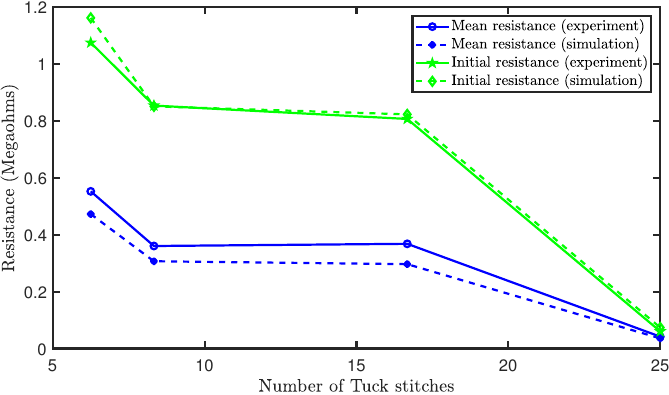
Figure 12. Initial and mean resistances of sensors with tuck